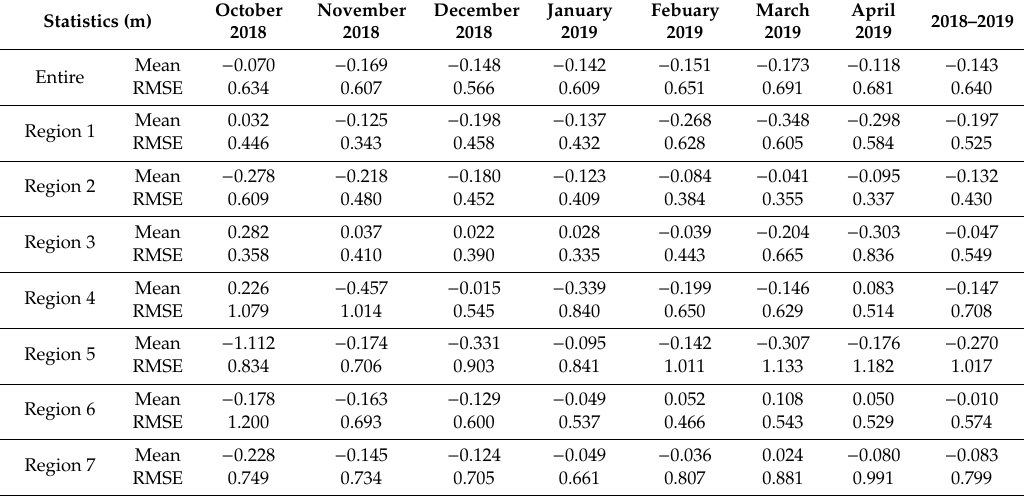
Table 4. Statistics of the sea ice thickness bias between the LSA and Centre for Polar Observation and Modelling